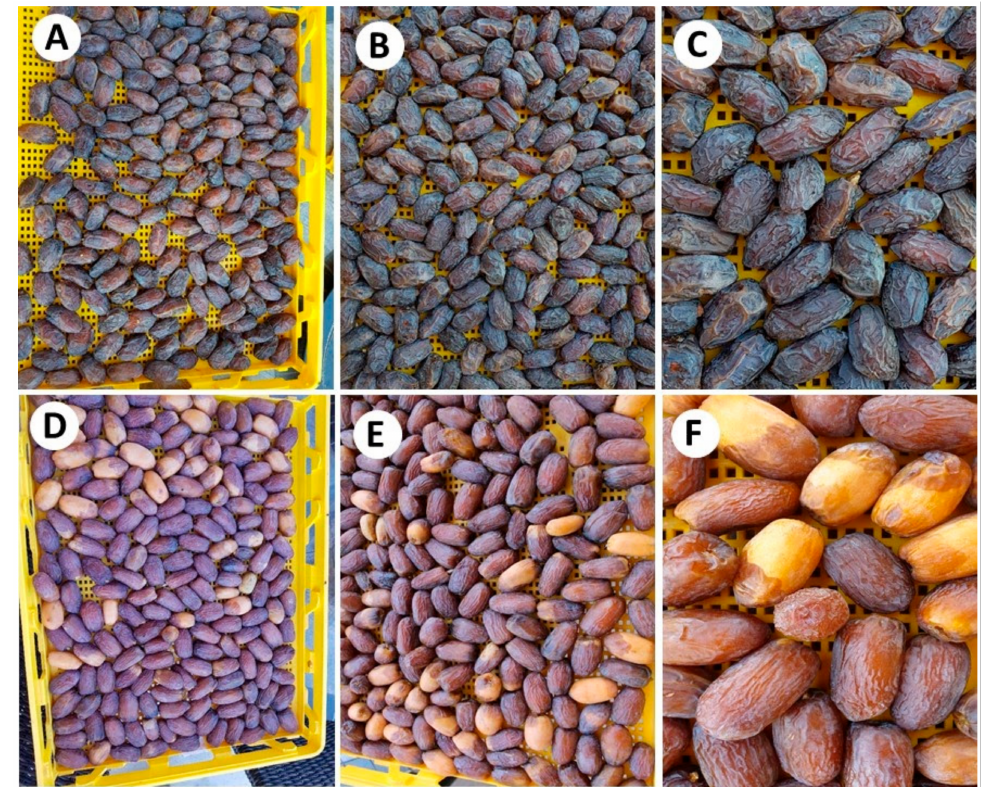
Figure 1. Example of dataset images. ( A – C ) Trays with ripe dates. ( D – F ) Trays with unripe dates.